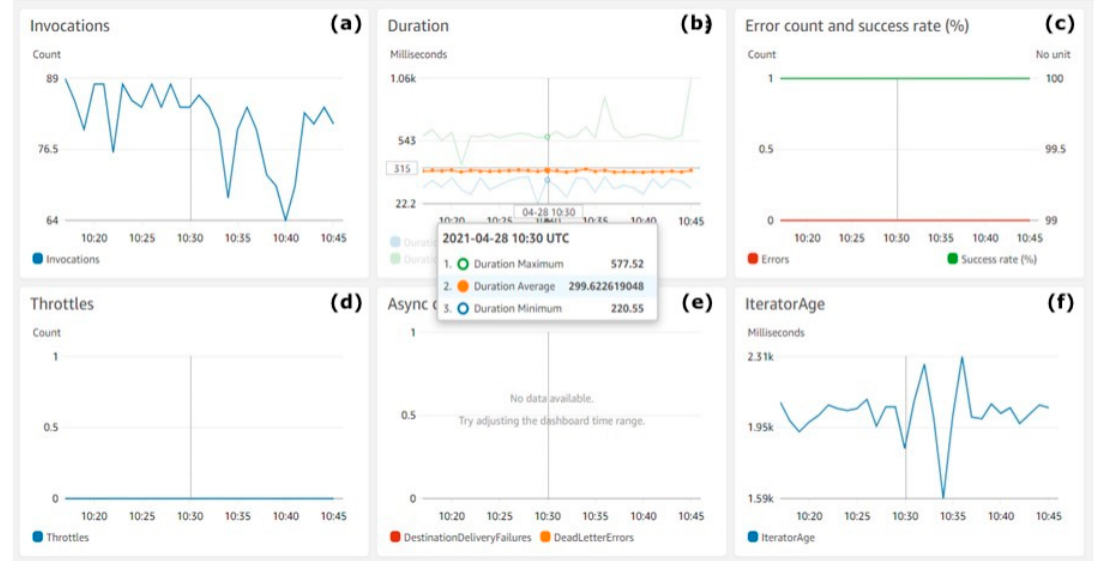
Figure 9. AWS Lambda performance metrics. ( a ) Invocations, ( b ) duration, ( c ) error count and success rate (%), ( d ) throttles, ( e ) async delivery errors, ( f ) iterator age.